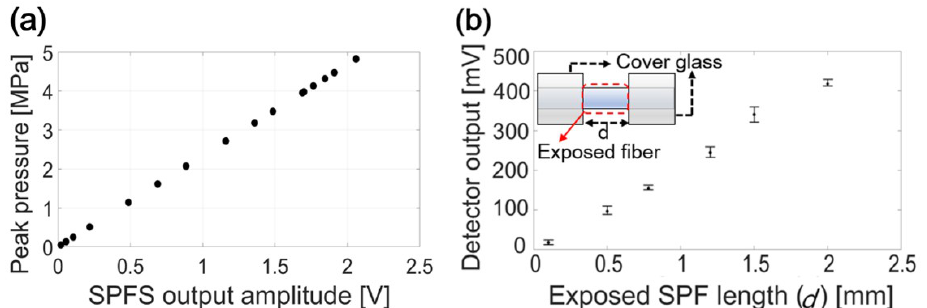
Figure 7. ( a ) SPFS output pressure amplitudes converted to the MPa unit (calibrated at 7-MHz frequency). An acoustic input is given from the 7-MHz piezoelectric transducer used as a source. ( b ) SPFS output signal amplitudes for different detector lengths. The inset shows a schematic to vary the exposed fiber length. An acoustic input is given from the CNT-PDMS transmitter.